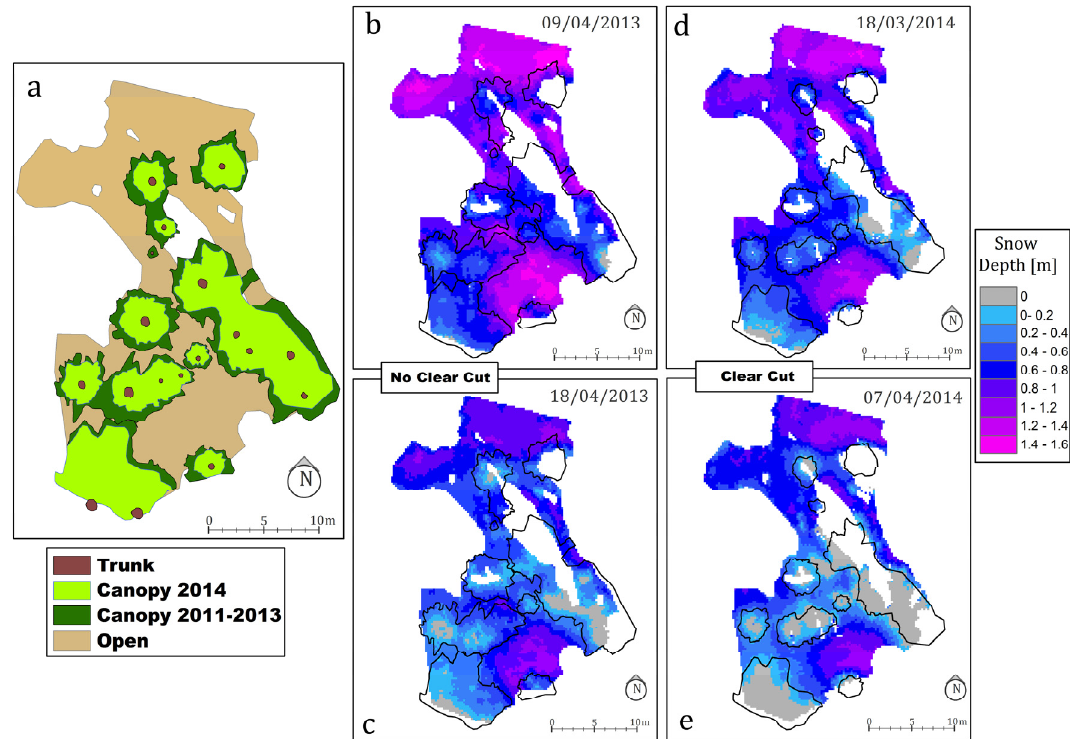
Figure 4. Canopy mask comparisons ( a ) prior to (2011–2013) and following (2014) tree branch pruning. The ( b , c ) and ( d , e ) maps show examples of four snow depth distribution maps obtained during the study period. The central maps were obtained prior to pruning and the right maps following pruning. Each map shows the canopy limit on each acquisition date.